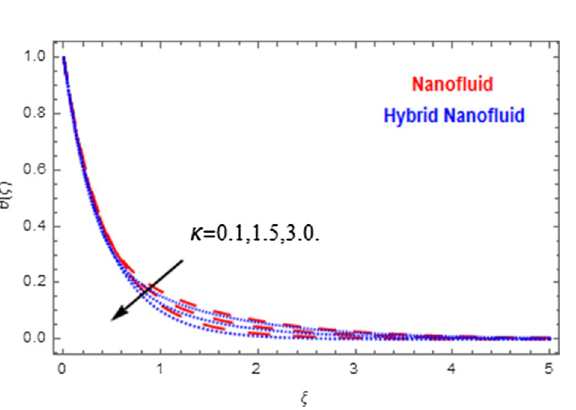
Figure 13. Variation in temperature field of nanofluid ( Al 2 O 3 ) and hybrid nanofluid ( Al 2 O 3 , Cu ) against different estimations of κ .